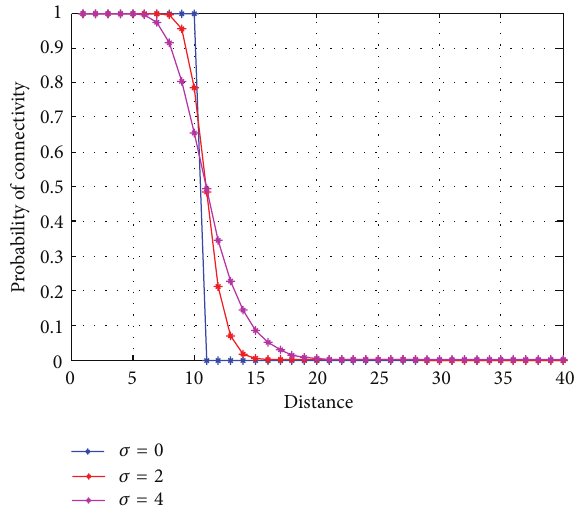
Figure 9: Probability of connectivity versus distance. 𝐾 -coverage and 𝐾 -connectivity are evaluated under log- normal shadowing model. Further we have studied the random shadowing effects which are incorporated into path loss and better describe received signal strength with distance in real environments. We have also shown the effect of node density and node failure probability on coverage. It has been observed that the probability of network coverage and connectivity depends on the node density and standard deviation. A higher value of standard deviation results in the decrease of average sensing radius of sensor node. Therefore, the probability of network coverage degrades. On the other hand high fading variance adds more links as compared to removed links thus improves connectivity. It can be concluded that log-normal path loss model and node density have a significant impact on coverage and